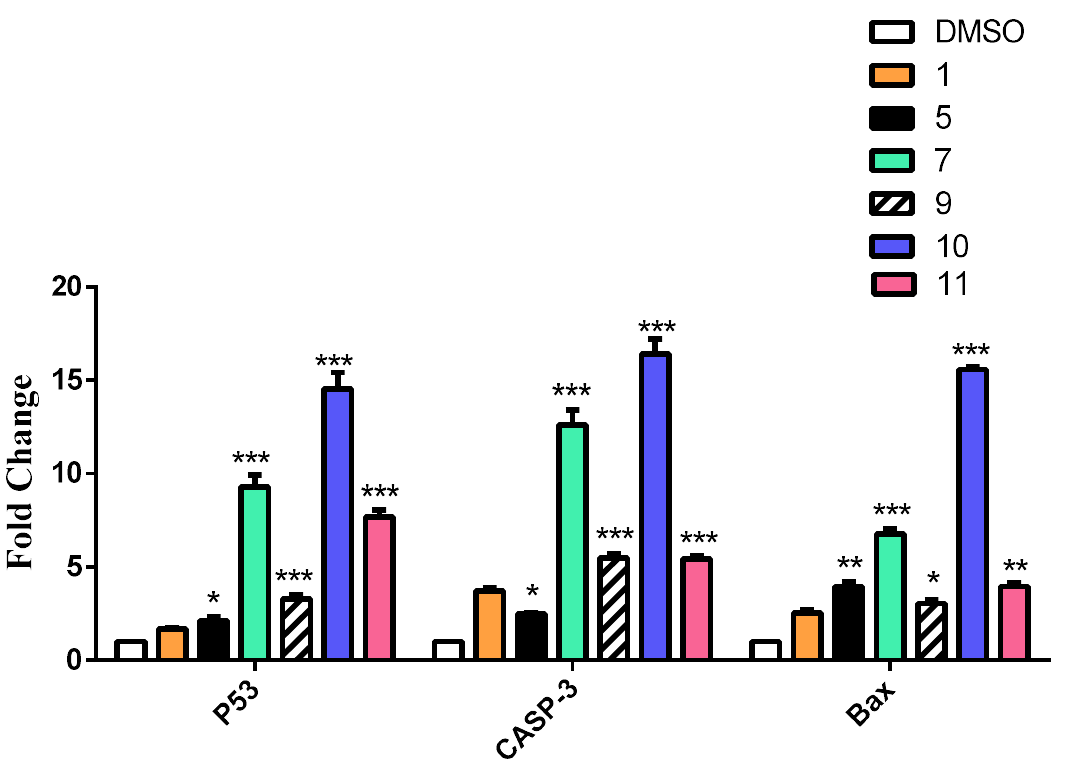
Figure 6. The effect of CA and its derivatives on the expression of P53, Caspase 3 and Bax genes by RT-qPCR. The results were represented as mean of fold changes ± SD. β-actin gene was used as a control gene. * Significant from CA at p < 0.05, ** Significant from CA at p < 0.01, *** Significant from CA at p < 0.001.